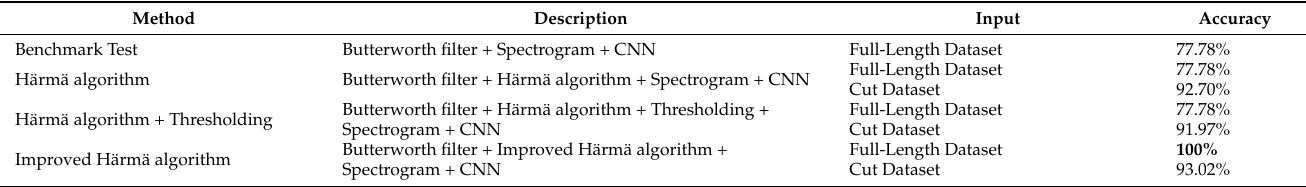
Table 5. A comparison among the